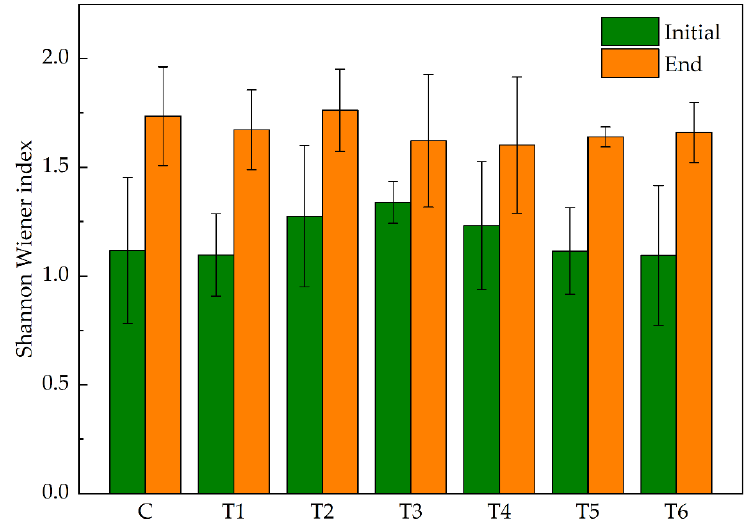
Figure 5. Shannon Wiener index of epiphytic algae at the initial and end of the experiment. Abbreviations for groups are the same as in Figure 1.